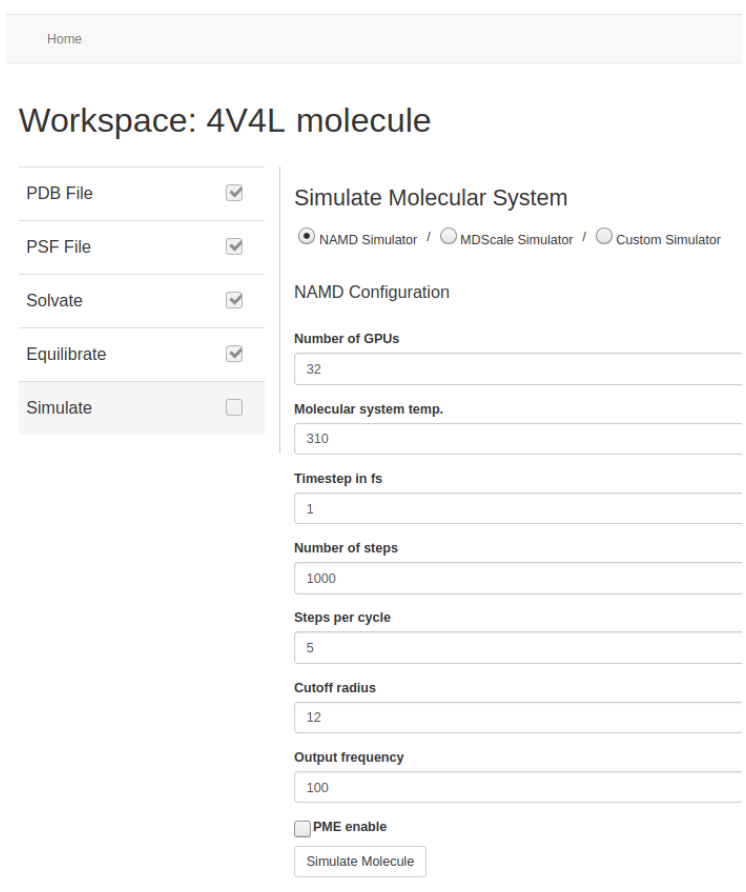
Figure 13. Configuration of the MD simulation using NAMD. Users can specify the details of the simulation and choose the number of GPUs to be